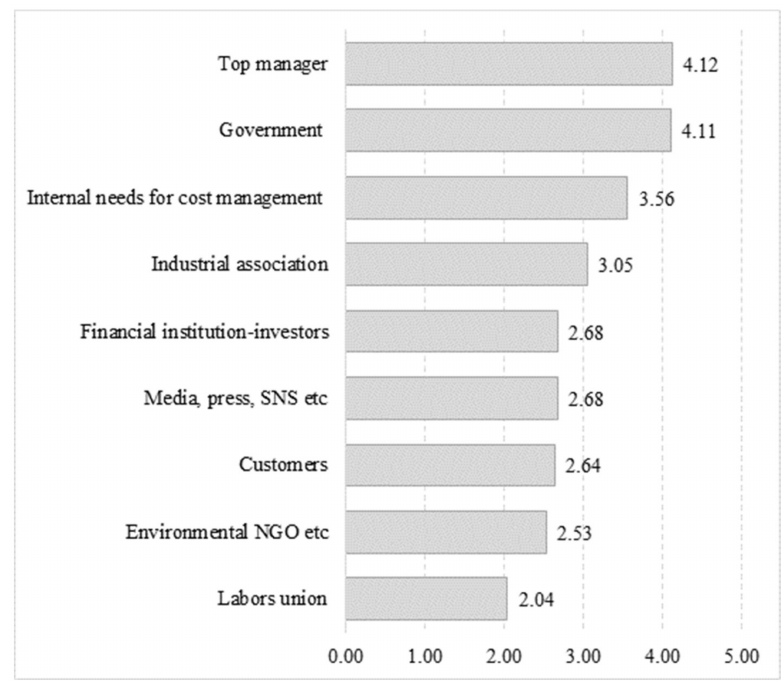
Figure 5. Influential stakeholders for Korean